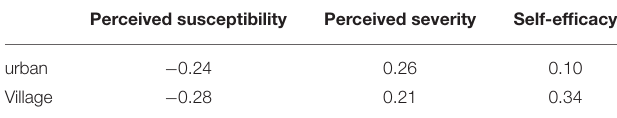
TABLE 4 | Coefficients of each dimension directly related to children’s medication adherence between parents of different genders.